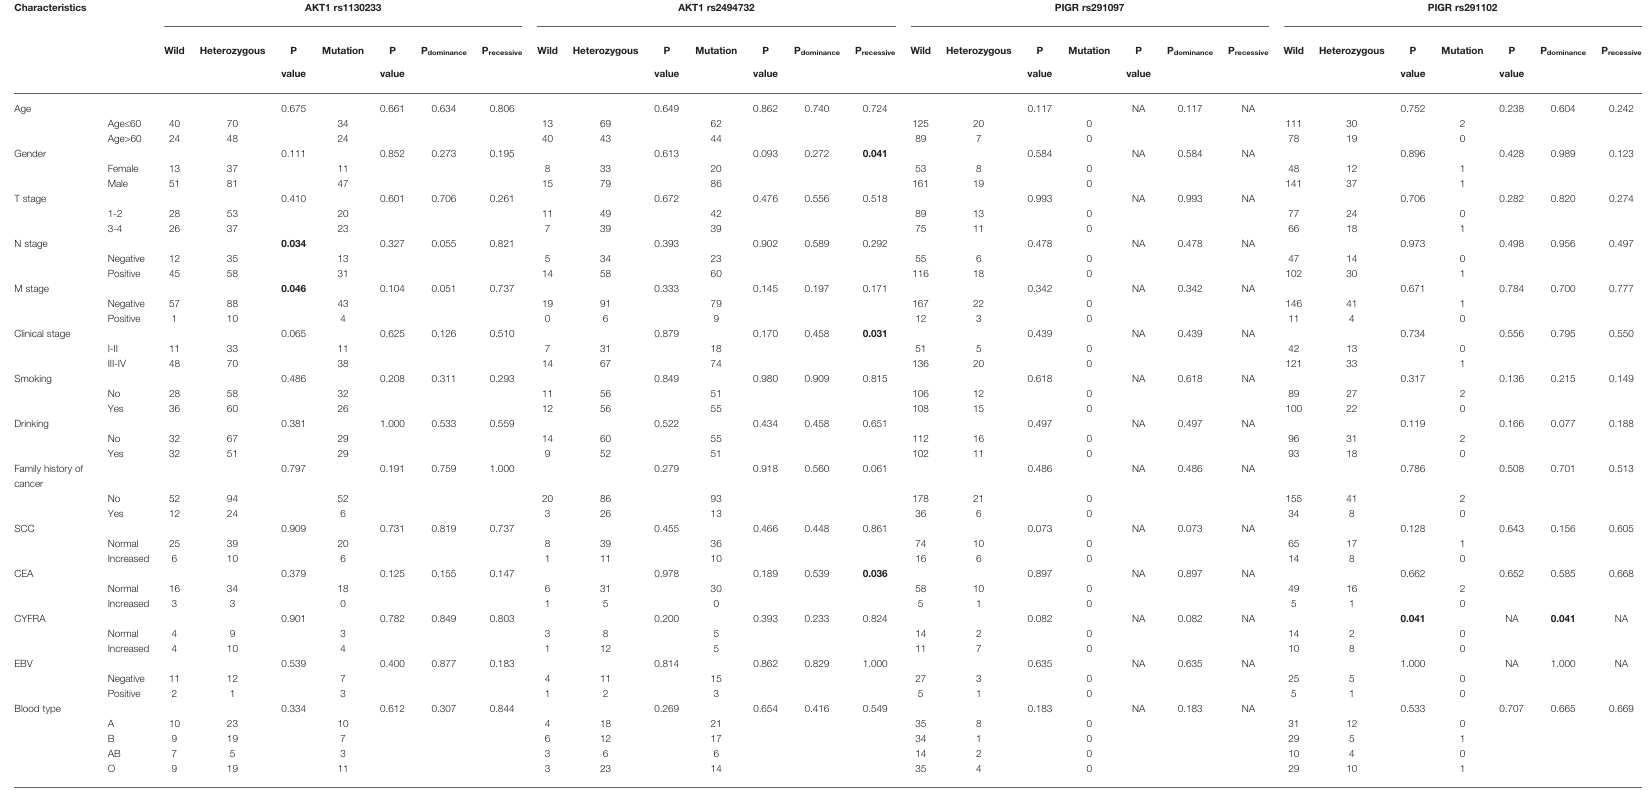
TABLE 6 | Association of signi fi cant in fl ammation-associated gene SNPs with clinicopathological parameters of HNSCC patients.